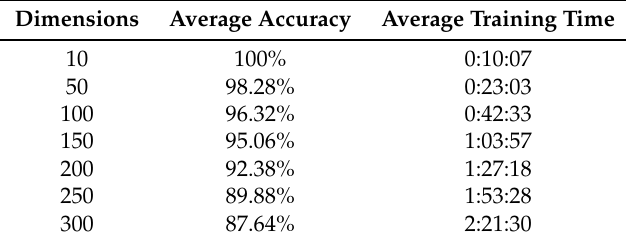
Table 3. Average accuracies and training times for Max-cut problems with different dimensions by RL.